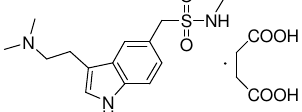
Figure.1. Structure of sumatriptan